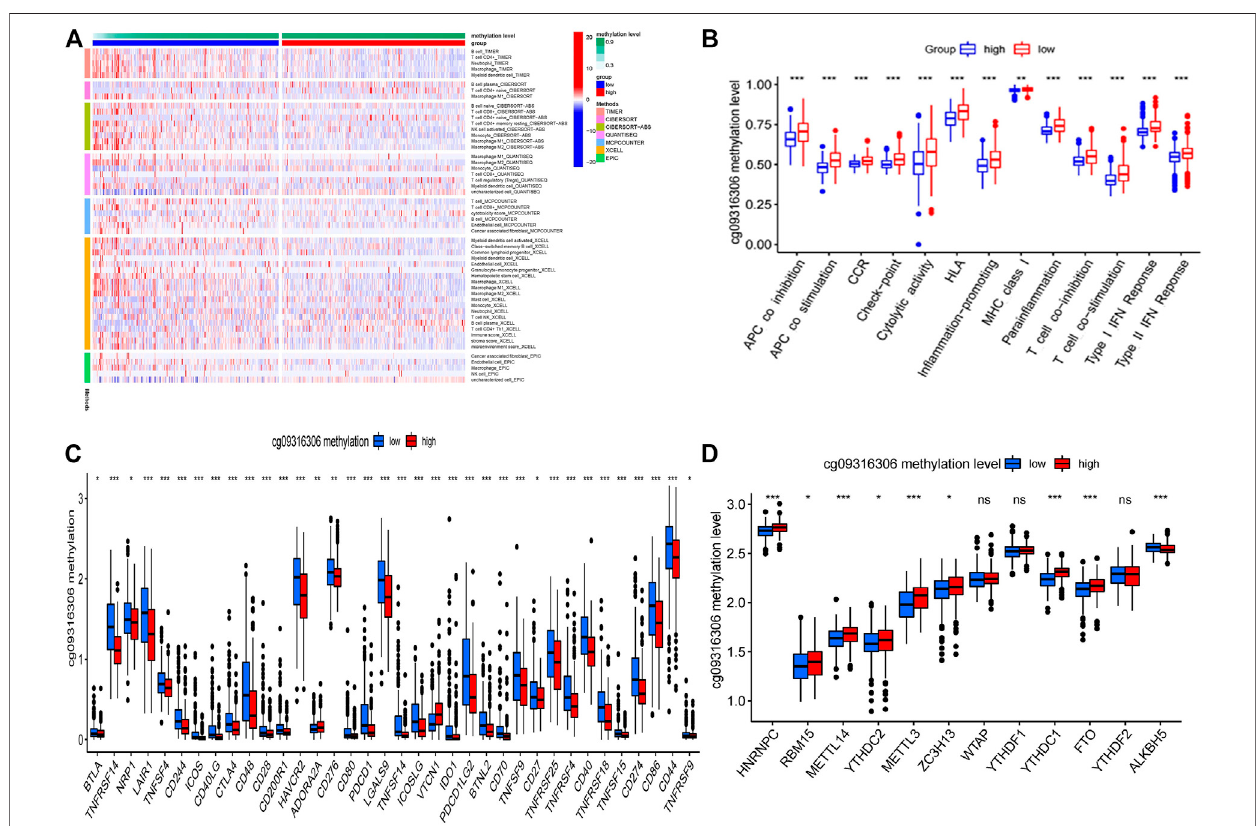
FIGURE 7 | The Correlation of TLR1 methylation site cg09316306 and immune cell in fi ltration. (A) the heatmap of immune responses based on different algorithms. (B) ssGSEA for the association between immune cell subpopulations and related functions. (C) immune checkpoints expression among the high and low groups. cg09316306 site methylation risk groups. (D) The expression of m6A-related genes between high and low cg09316306 site methylation risk